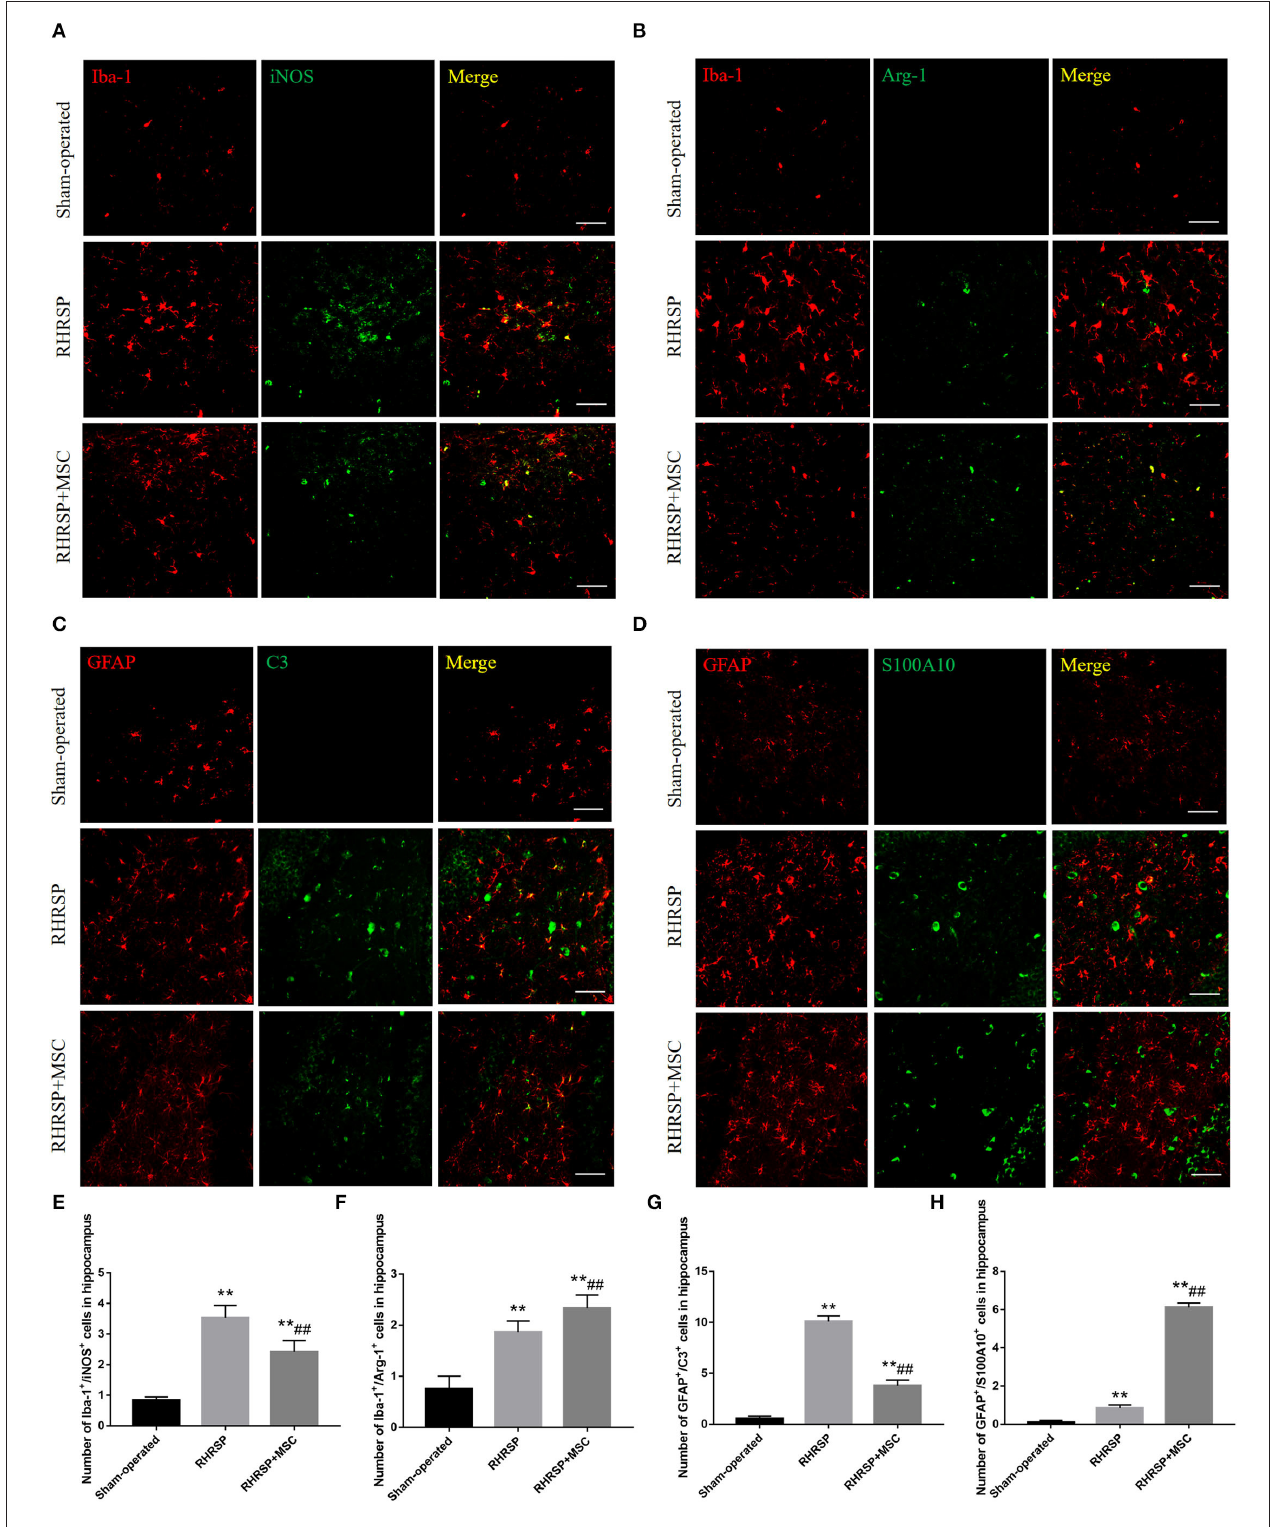
FIGURE 8 | Effects of MSCs treatment on the phenotype distribution of microglia and astrocytes. (A–D) Double immunofluorescence staining of Iba-1/iNOS-positive M1 microglia, Iba-1/Arg-1-positive M2 microglia, GFAP/C3-positive A1 astrocytes and GFAP/S100A10-positive A2 astrocytes in hippocampus. (E–H) Representative quantification showing that MSC significantly decreased the number of M1, A1 cells and increased the number of M2, A2 cells in hippocampus. (** P < 0.01, vs. Sham-operated group, ## P < 0.01, vs. RHRSP group; n = 6/group). scale bar = 50 µ m.